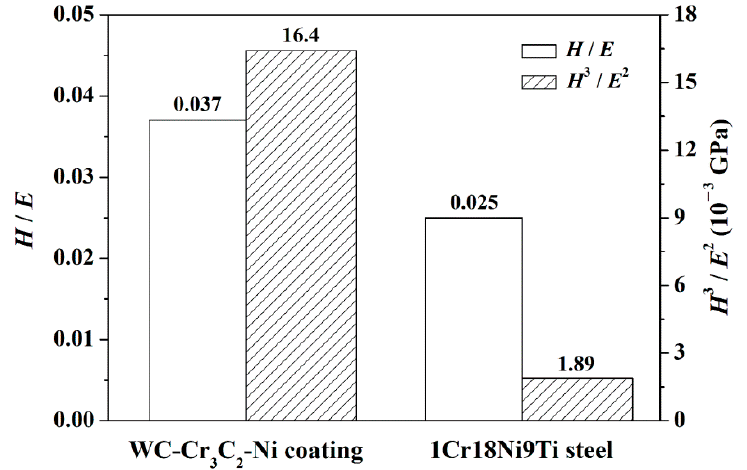
Figure 5. Nanomechanical properties of the WC-Cr 3 C 2 -Ni coating and the 1Cr18Ni9Ti stainless steel.